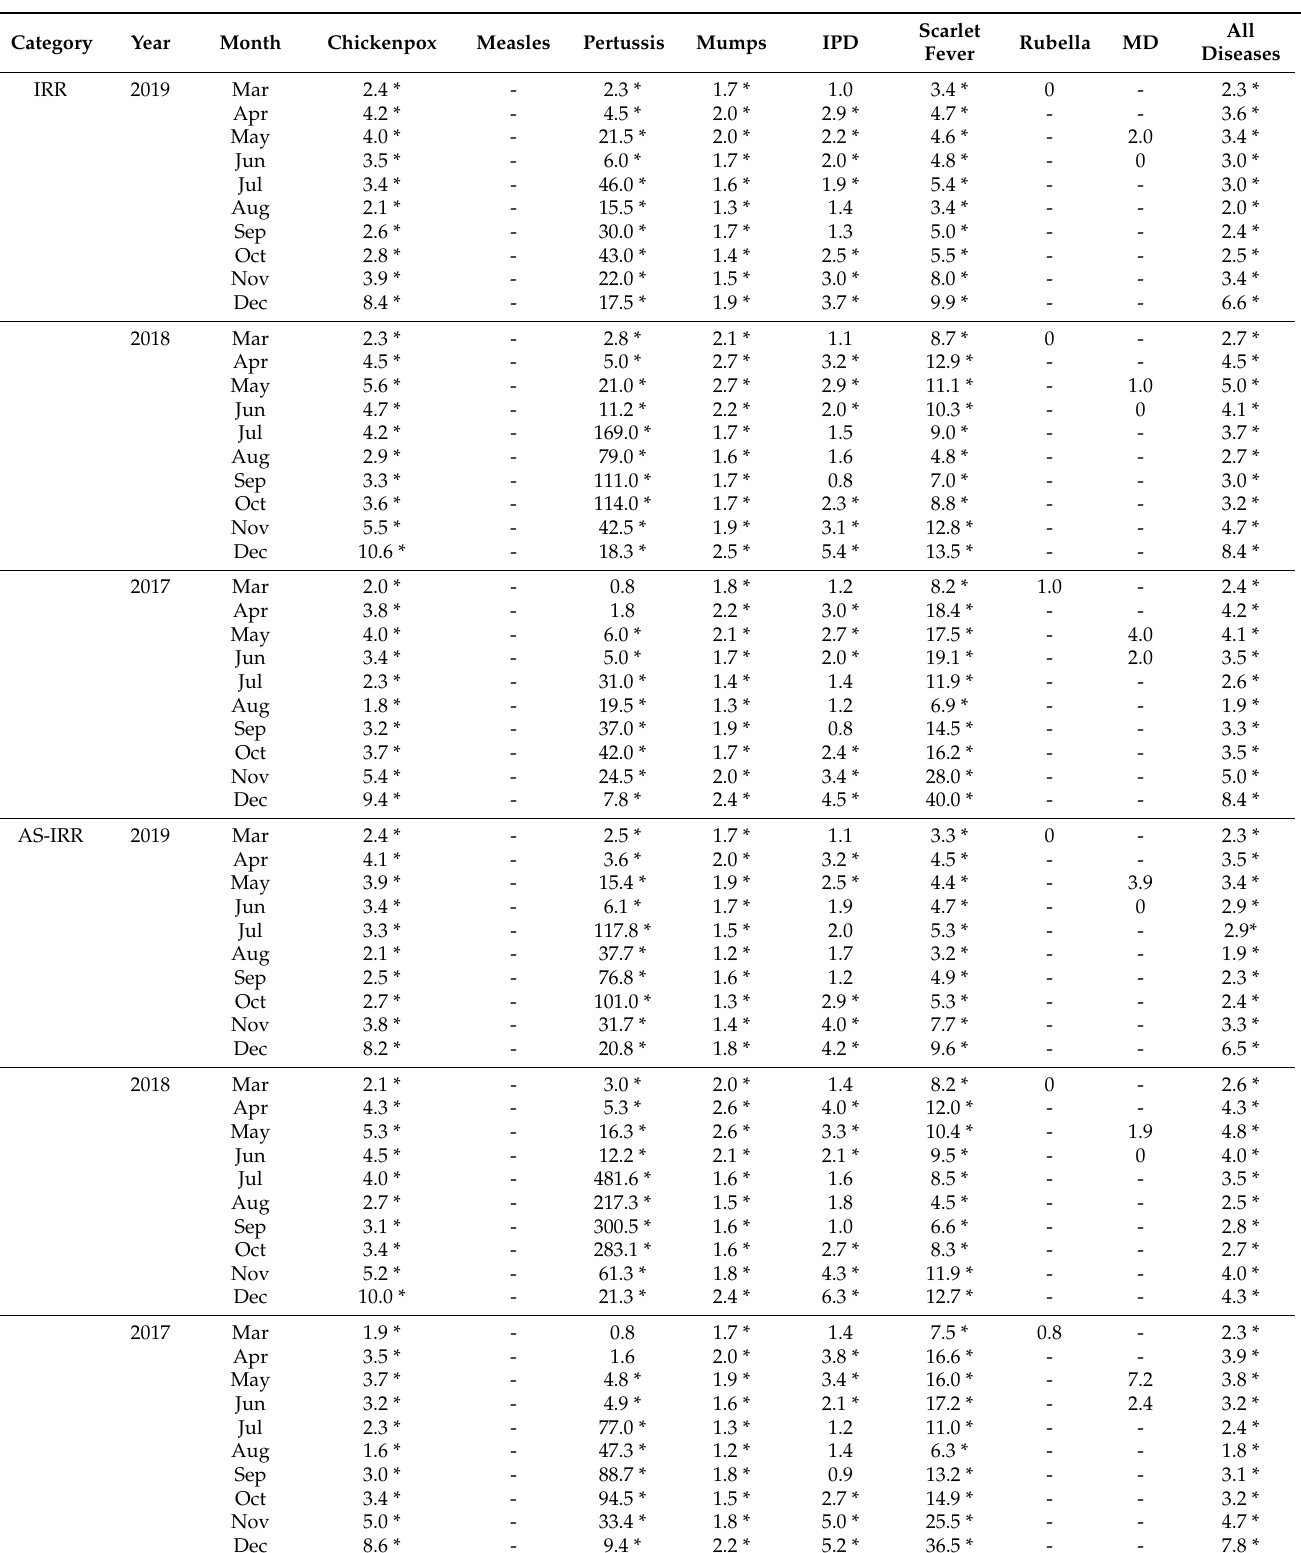
Table 4. Monthly IRRs and AS-IRRs for eight infectious respiratory